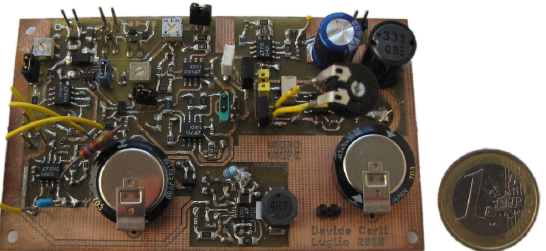
Figure 10. Picture of the assembled multi-source energy harvester. The wind energy harvesting section is on the rightmost side: from top downwards, the radial electrolytic capacitor C 1 , the radial inductor L , the trimmer R 3 and the supercapacitor C 2 are clearly